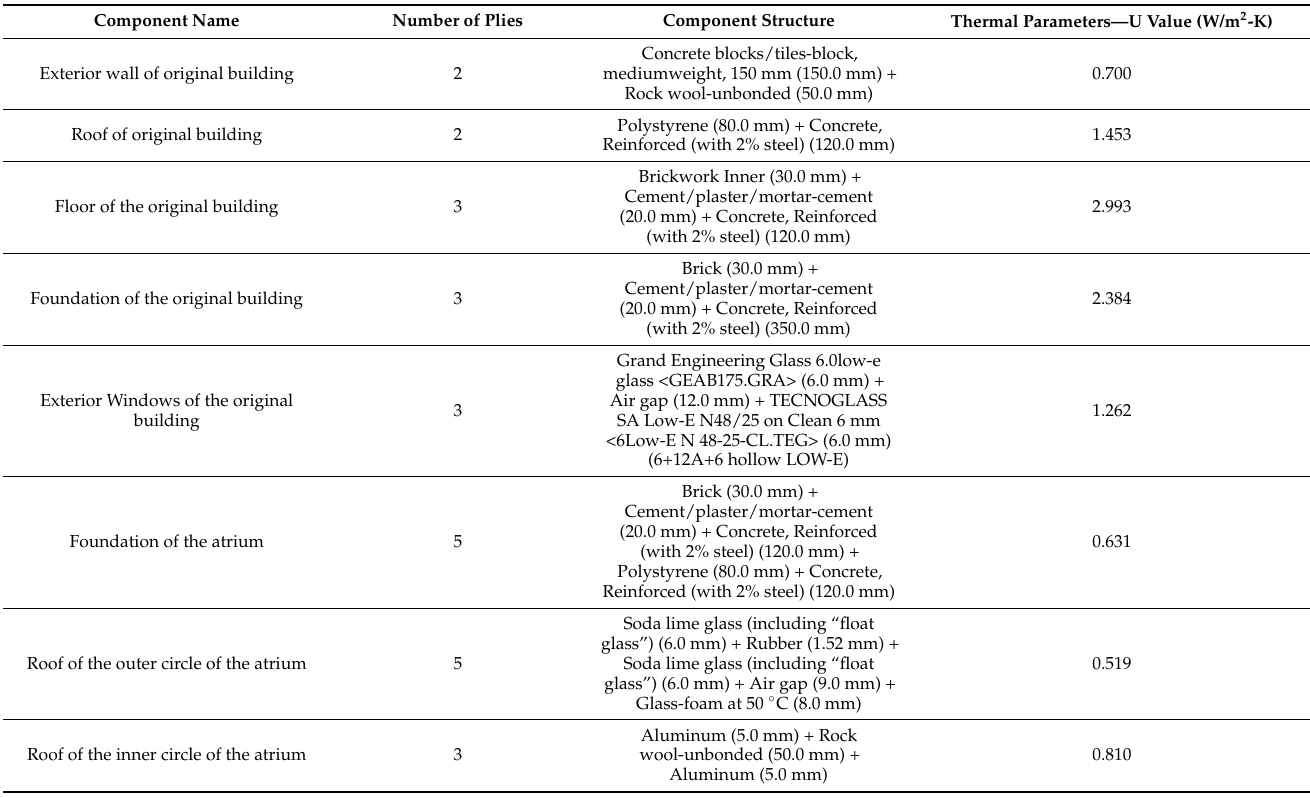
Table 2. Building construction parameters.